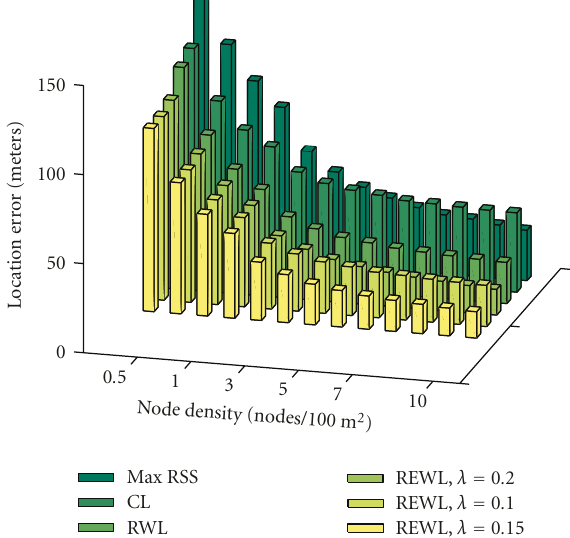
Figure 3: Algorithm location error by node density for 2.4 GHz.